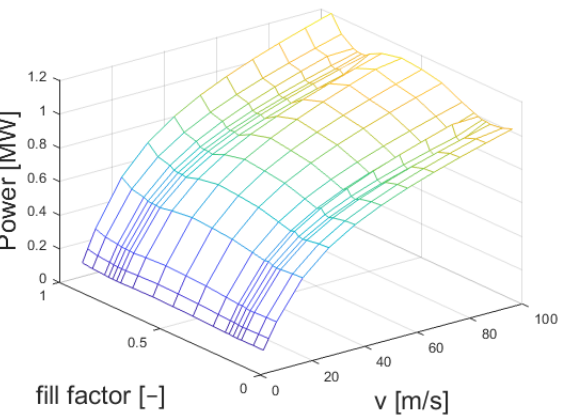
Figure 8. Instantaneous power required to overcome the braking forces. Power consumption as a function of fill factor and velocity.